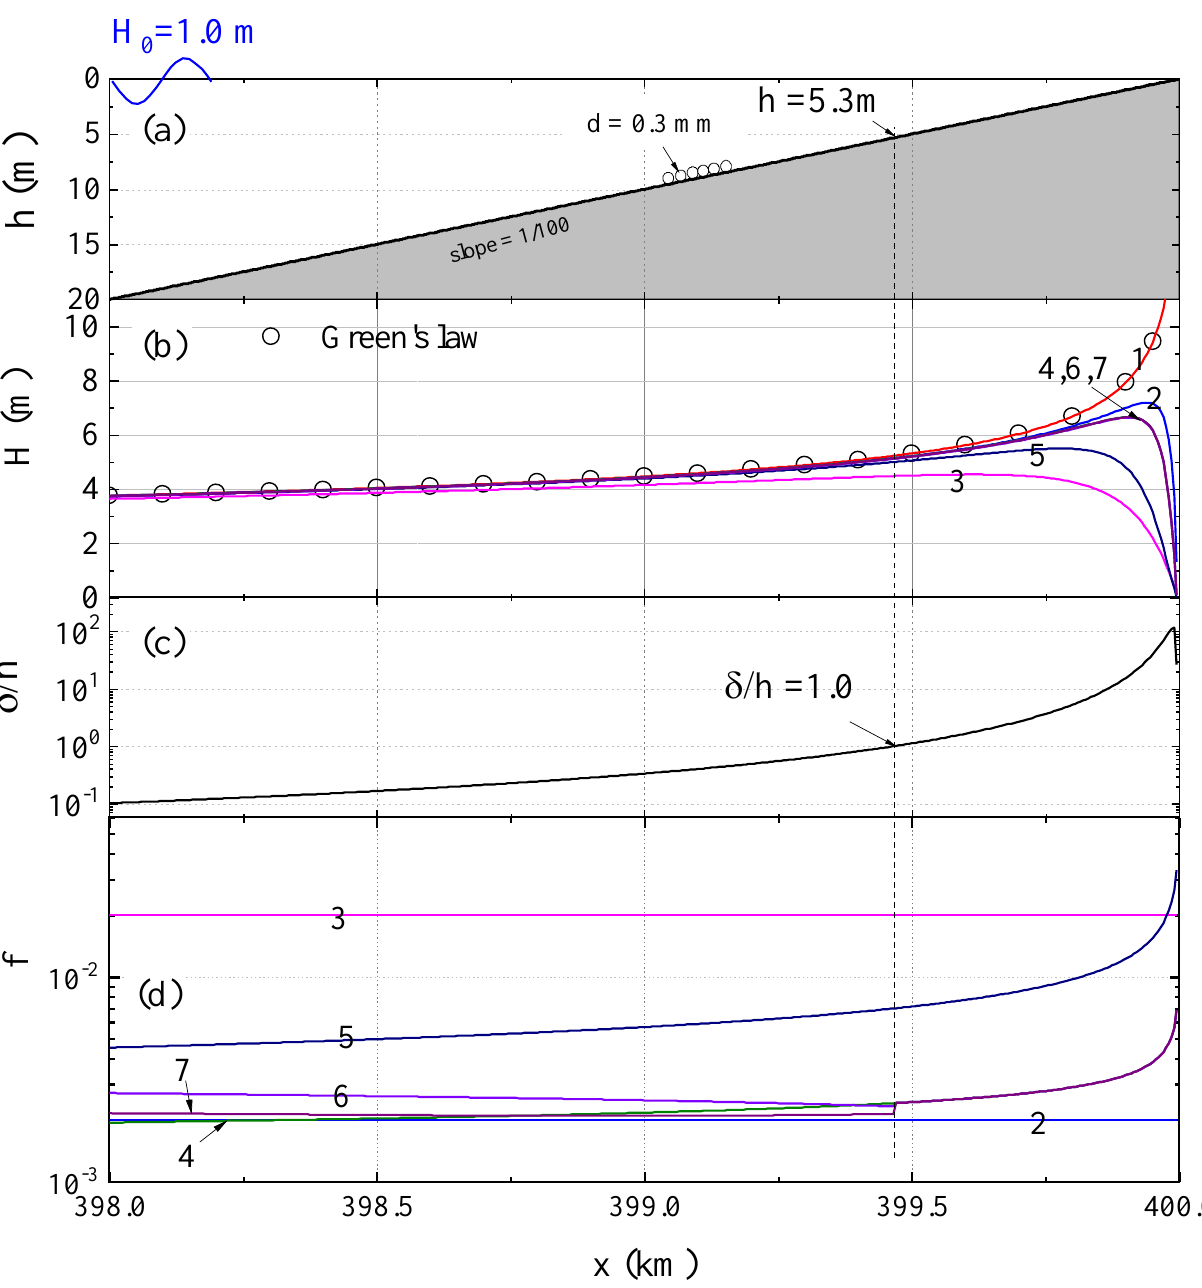
Figure 7. Computation results (shallow sea region enlargement): ( a ) Bathymetry. ( b ) Wave height. ( c ) Dimensionless boundary layer thickness. ( d ) Friction coefficient.